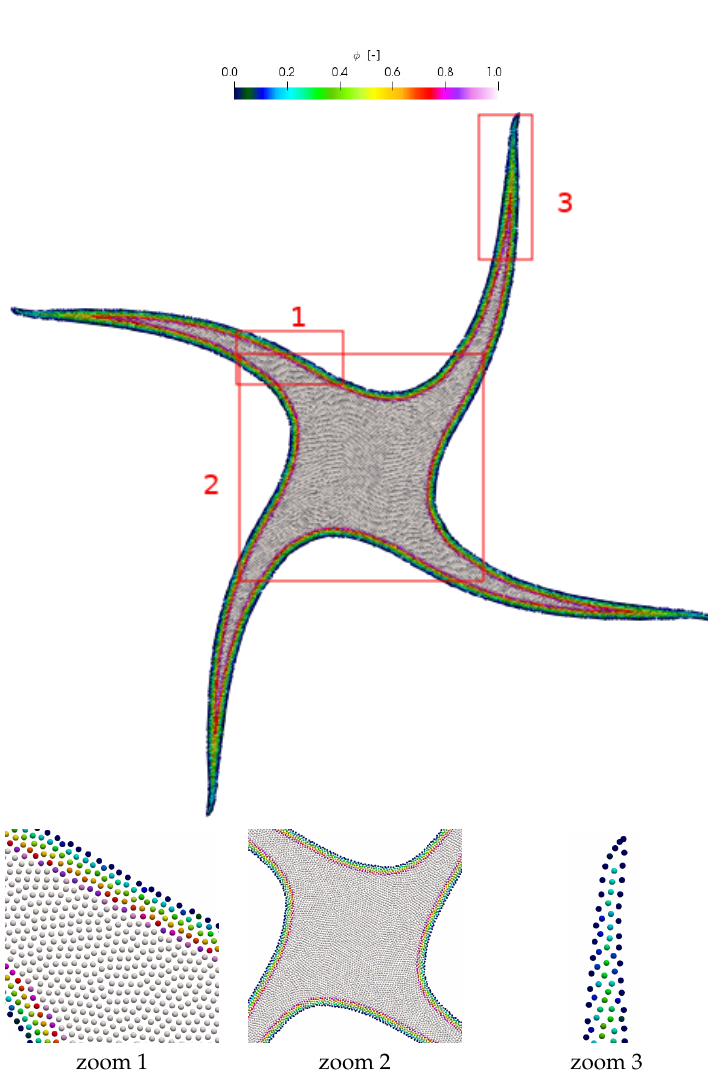
Figure 18. Evolution of an initially-square fluid patch: The fluid particles distribution at the dimensionless time t ω = 2.2 in the case of poor detection free surface. The particles are colored with dimensionless φ -parameter field. The second row presents the zooms on the three selected regions.